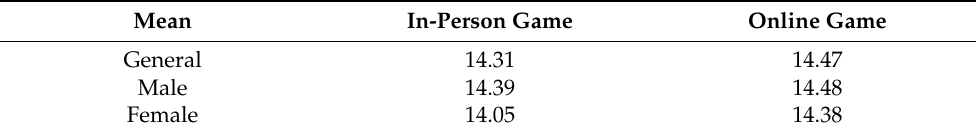
Table 3. Mean age of initiation in gambling depending on the modality and gender. Mean In-person Game